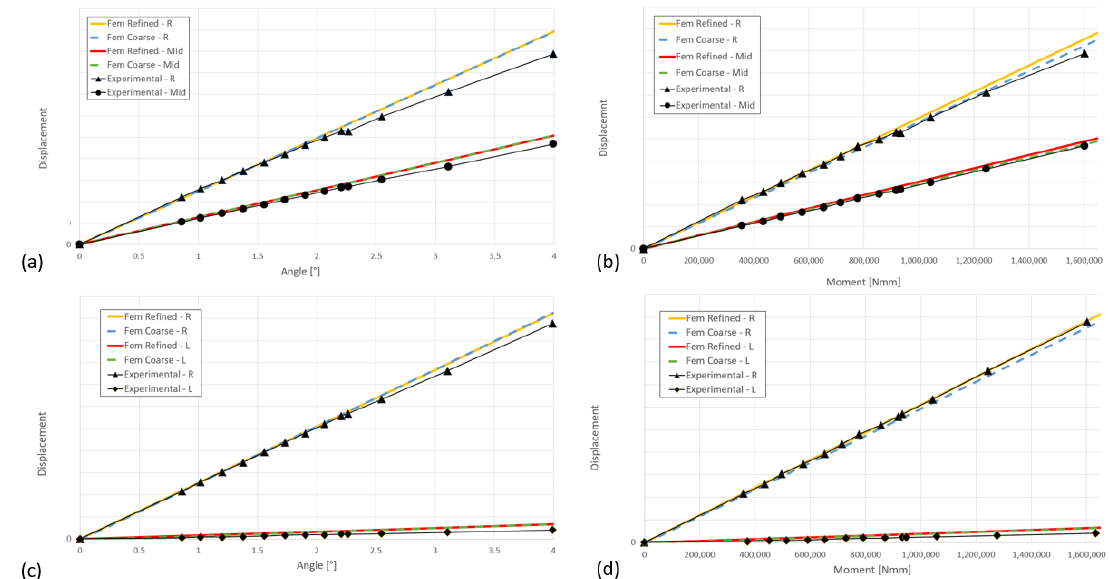
Figure 10. Comparison between experimental and FE displacement for the differential torsion: ( a ) measured at laser position, as a function of the rotation angle, ( b ) measured at laser position, as a function of the moment applied on the right side, ( c ) measured at cable position, as a function of the rotation angle, ( d ) measured at cable position, as a function of the moment applied on the right side.